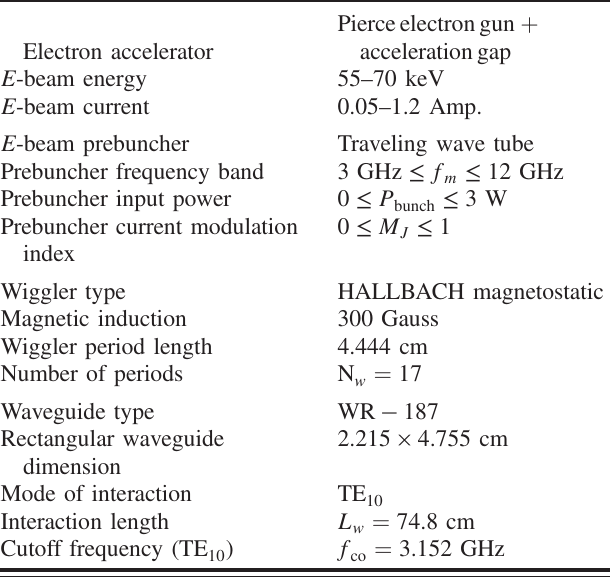
TABLE I. The parameters of the prebunched beam FEM experimental setup.